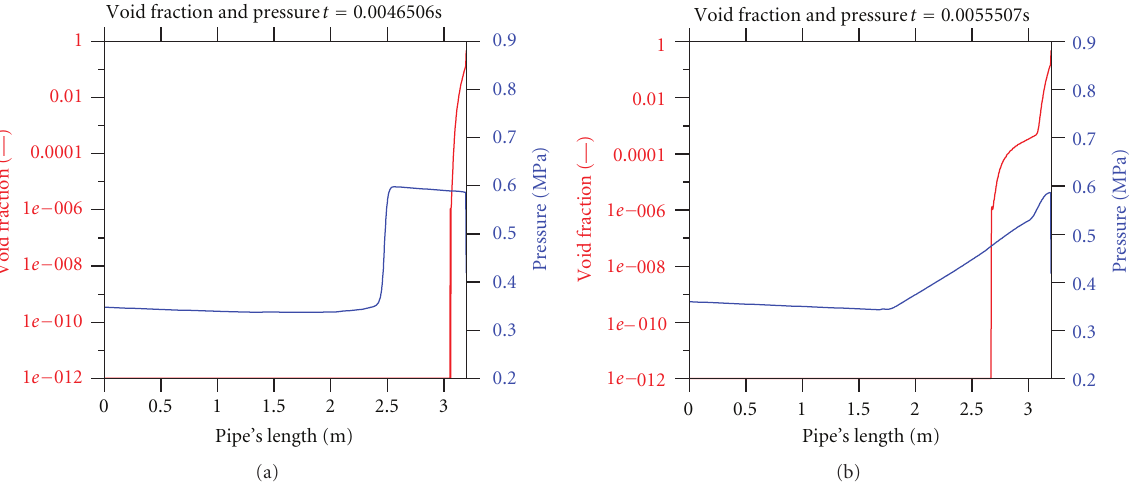
Figure 3: Rarefraction (a) and reflected compression (b) wave.